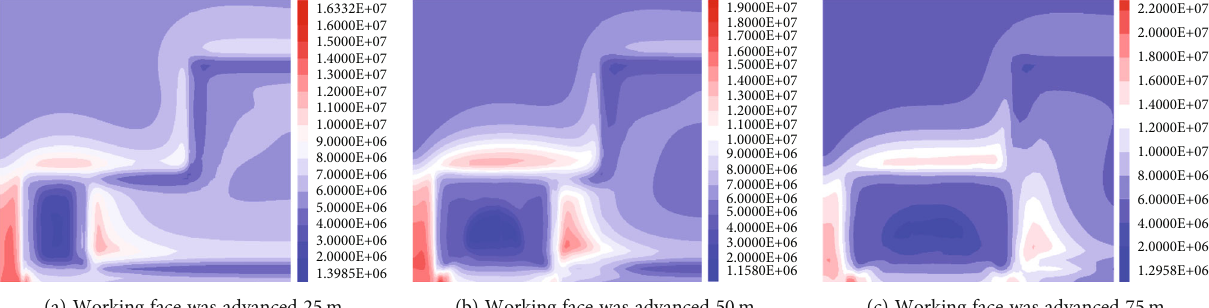
Figure 24: Maximum shear stress of small mining